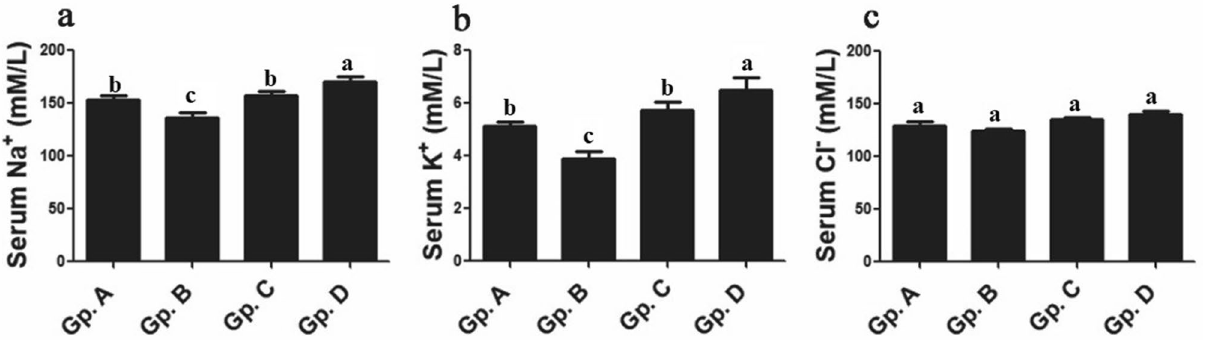
Figure 6. Effect of temperature changes on electrolyte’s parameters ( a : Na + ; b : K + & c : Cl − ) in the different experimental groups of Dabb lizard ( U. aegyptia ). Gp. A: control group; Gp. B: low temperature exposed group; Gp. C: moderate temperature exposed group; Gp. D: high temperature exposed group; Na + : sodium; K + : potassium; Cl − : chloride. abc Means above each bar with different letters in different Dabb groups i.e. Gp. A, Gp. B, Gp. C and Gp. D, were significantly different ( P <